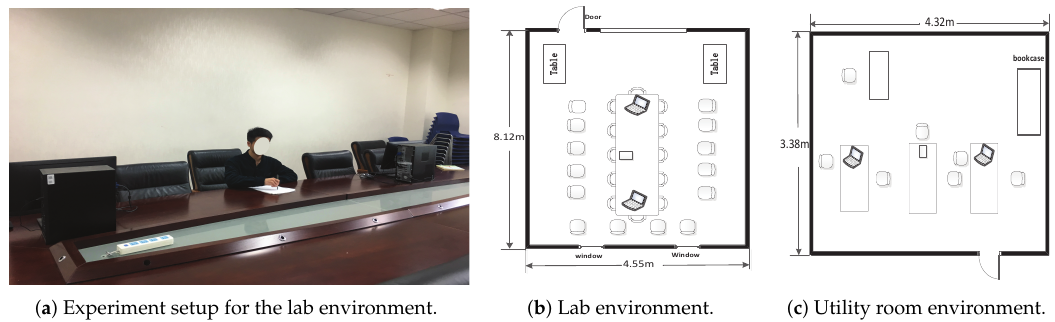
Figure 8. Floor plan and measurement settings of the lab and utility room environments.